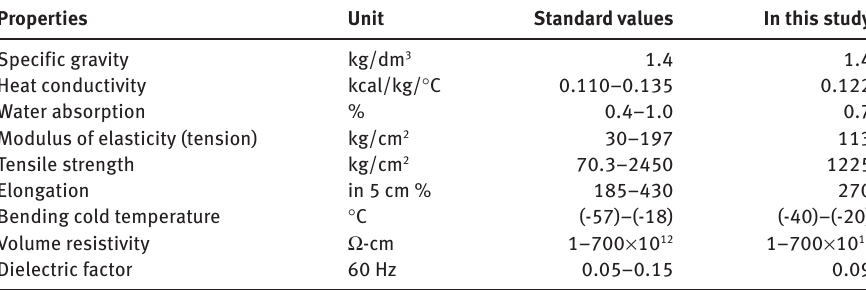
Table 3 Polyvinyl chloride additives properties.